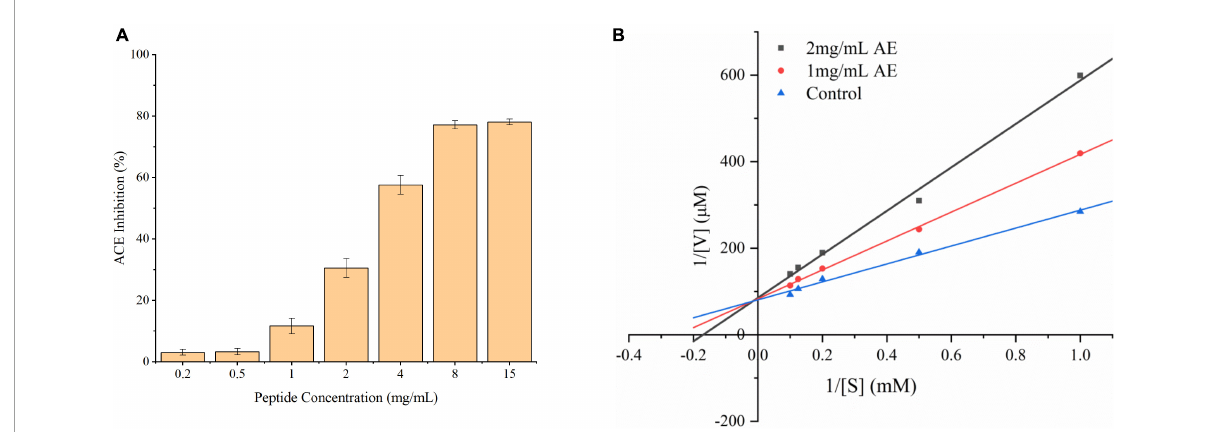
FIGURE2 (A) ACE-inhibitory activity of the peptide AEYLCEAC determined by HPLC. The IC 50 value was calculated by regression equation: Y = − 0.0073X 2 + 0.1616X-0.0105 ( R 2 = 0.99). (B) Line weaver-Burk plot of ACE inhibition by AEYLCEAC. The ACE activity was measured with various concentrations of the peptide AEYLCEAC. ( (cid:4) : 2 mg/mL AEYLCEAC; • : 1 mg/mL AEYLCEAC; (cid:78) : control).